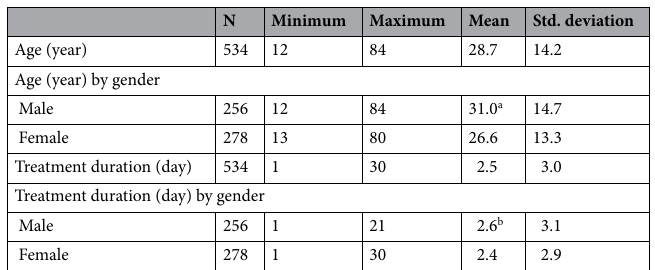
Table 2. Frequency distribution of age and treatment duration of inpatients’ acute poisonings. a p < 0.001 (Z = − 4.786). b p = 0. 679 (Z = − 0.